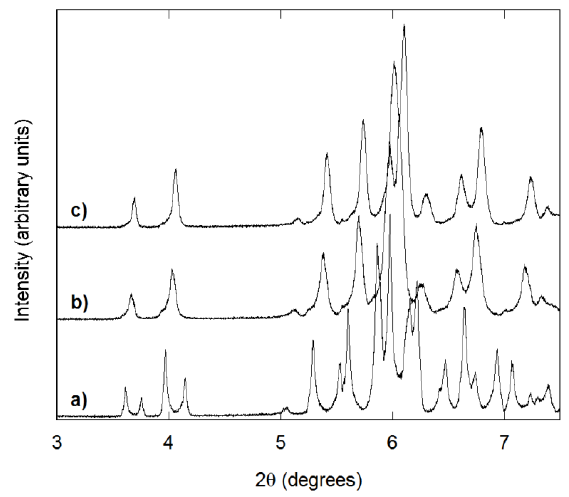
Figure 3. Synchrotron diffraction patterns of AlScMo 3 O 12 samples prepared in 15 mL